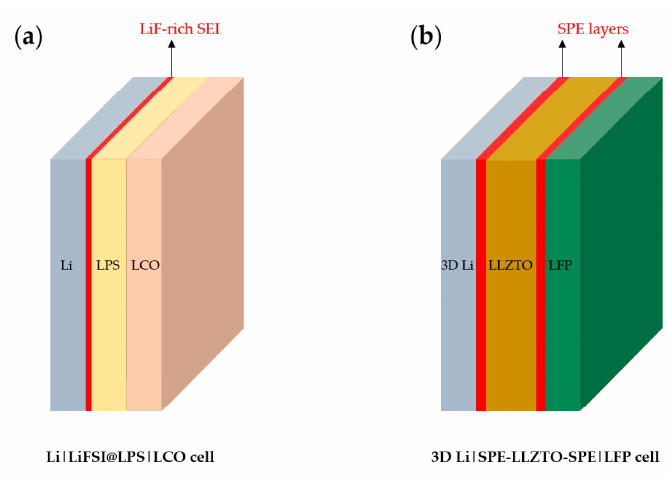
Figure 15. Electrolyte interphase layers between electrolytes and electrodes. ( a ) Scheme of Li|LiFSI@LPS|LCO cell. ( b ) Scheme of 3D Li|SPE-LLZTO-SPE|LFP cell.